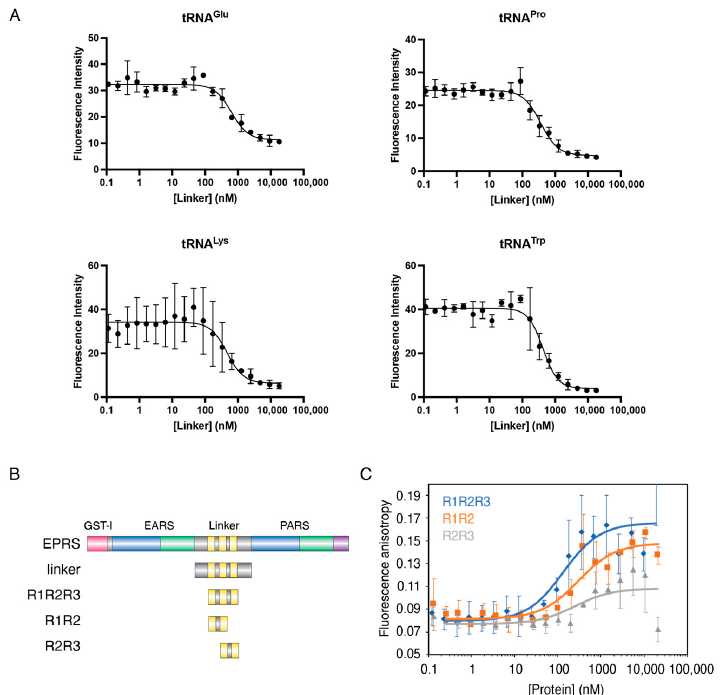
Figure 4. Interaction of EPRS linker with tRNAs in vitro. ( A ) Purified EPRS linker protein was titrated into 5 nM in vitro transcribed, fluorescently labeled tRNA (Glu, Pro, Lys3, or Trp, as indicated). Average fluorescence quenching curves are shown, with the error bars representing the standard deviation of three independent experiments. ( B ) Schematic of full-length EPRS and linker fragments used in this study. ( C ) Graph showing results of FA binding assays wherein purified EPRS linker fragments were titrated into 5 nM tRNA Lys3 . Data were analyzed as previously described [48]. Each curve is the average of three independent experiments with the standard deviation indicated.